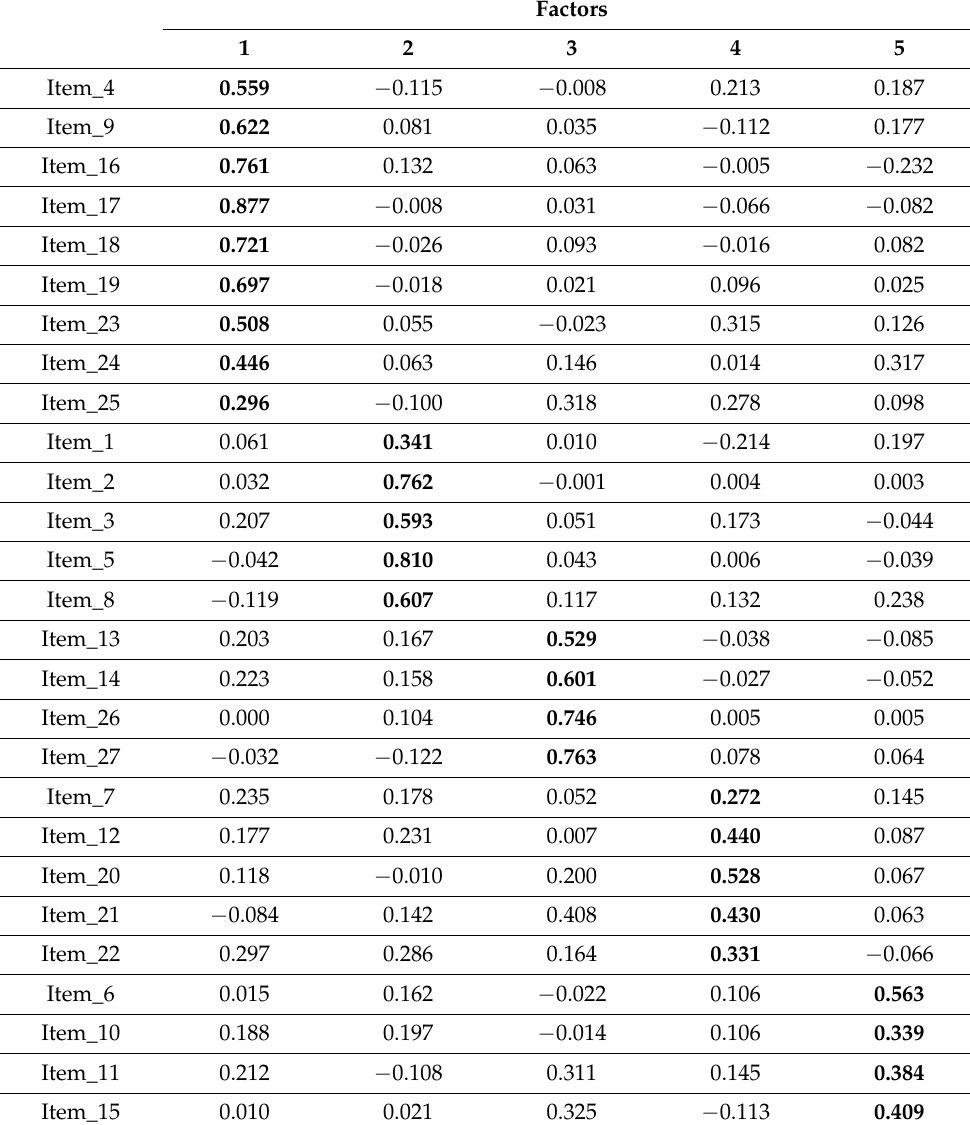
Table 2. Exploratory factor analysis ( n = 300). Rotated factor